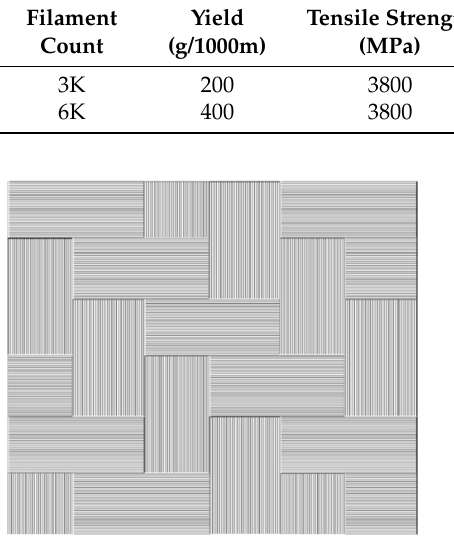
Figure 1. Representation diagram of 2 × 2 twill weave pattern.